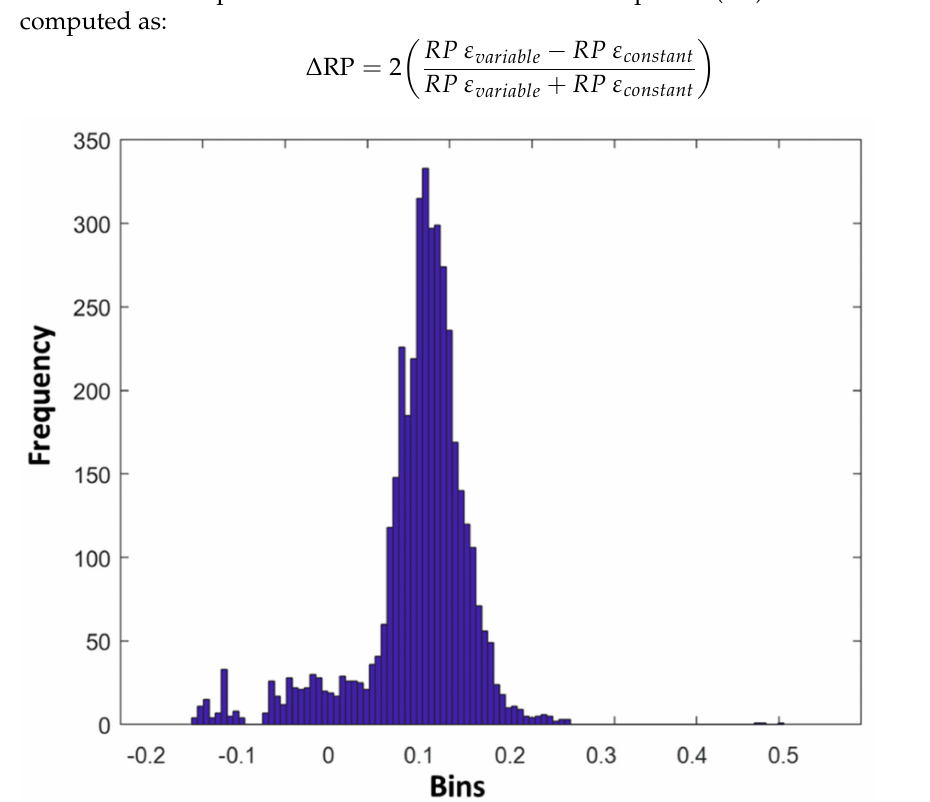
Figure 9. Histogram of the difference between the radiant heat flux for variable emissivity and constant emissivity computed for ~4000 theoretical pixels. The median value is 0.15 and the standard deviation is